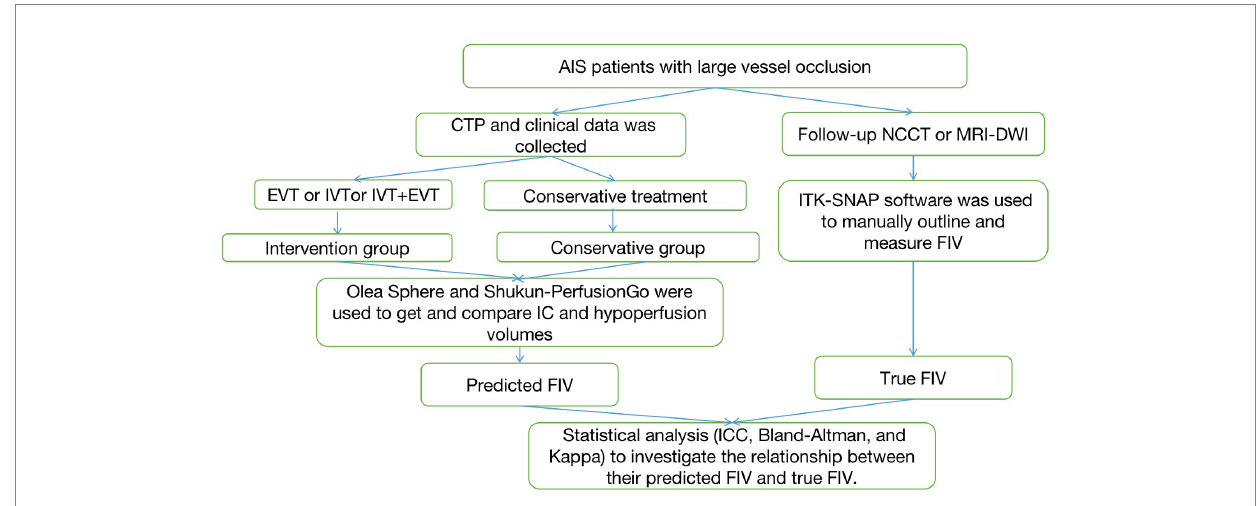
FIGURE 1 The flowchart of the proposed approach. AIS, acute ischemic stroke; NCCT, non-contrast CT; IVT, intravenous thrombolysis; EVT, endovascular thrombectomy; FIV, final infarct